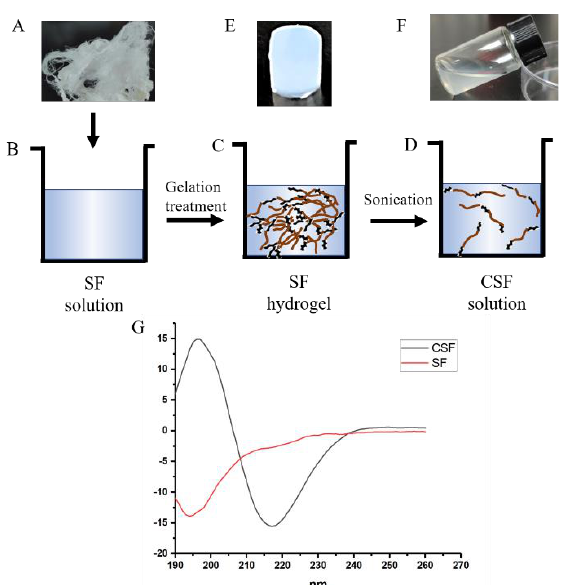
Figure 1. Scheme of the strategy to prepare CSF solution. Degummed silk fiber ( A ) was dissolved to form fresh silk fibroin solution ( B ), and then the solution was gelation treated to obtain silk fibroin hydrogel ( C ). Finally, the hydrogel was ultrasound treated, and this led to the formation of a CSF solution ( D ). ( E , F ): the morphology of silk fibroin hydrogel ( E ) and the CSF solution ( F ); ( G ): CD curves of fresh silk fibroin solution and the CSF solution.